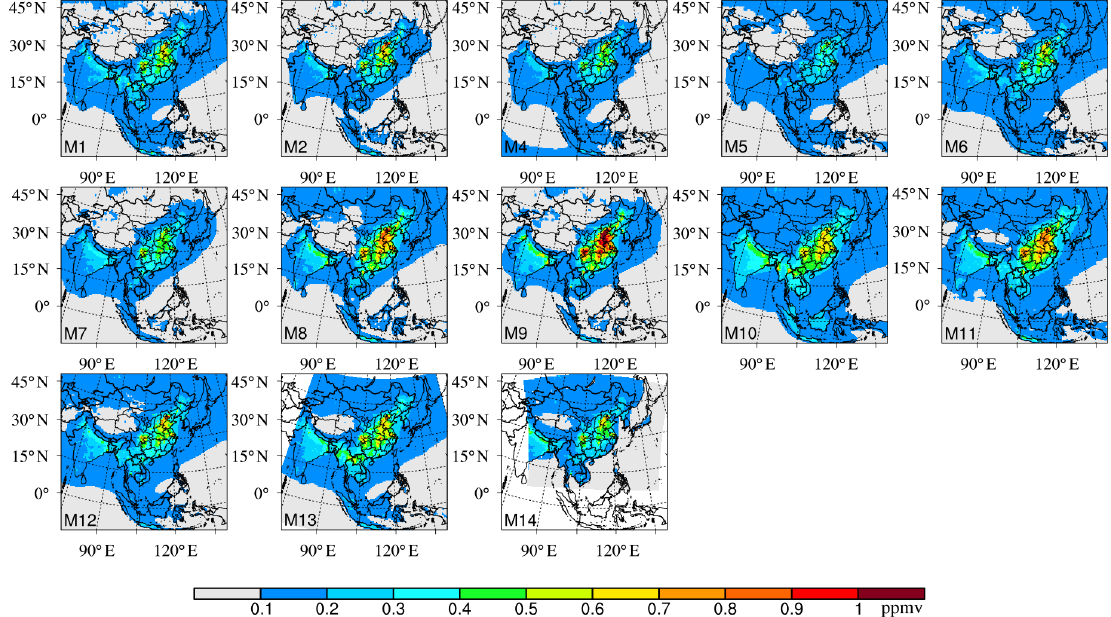
Figure 7. Spatial distribution of the annual mean CO concentrations from each modeling results of MICS-Asia